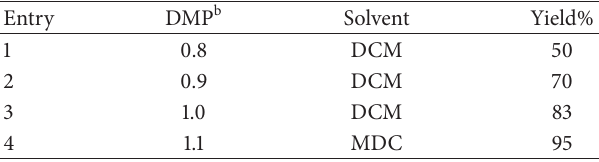
Table 2: Reagent mole equivalent optimization